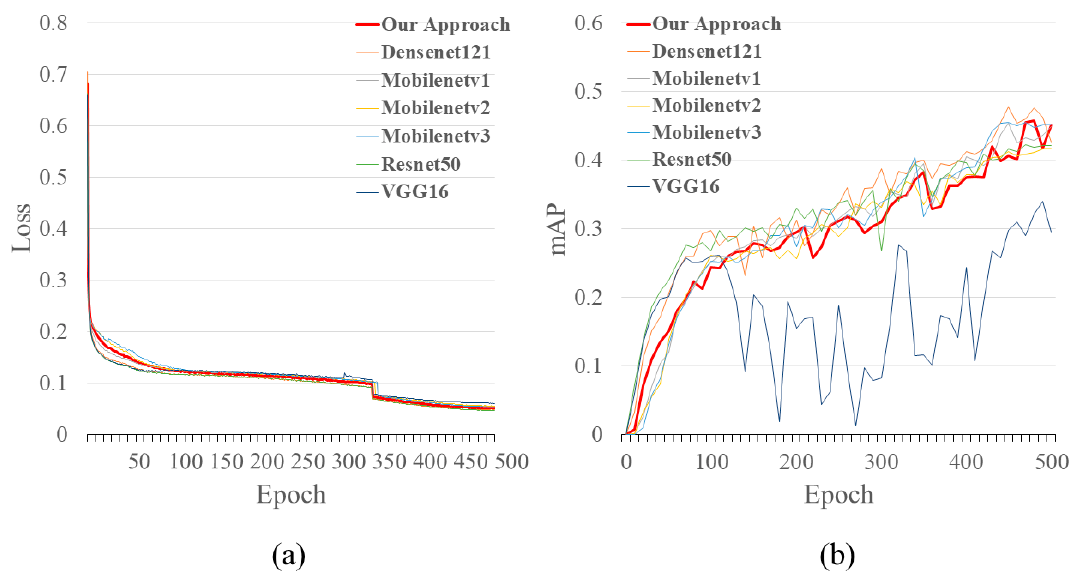
Figure 8. The upward trend of ( a ) loss function convergence status and ( b ) mAP for each model at 500 training epochs. Table 9. Comparison of quantitative experimental results on the same test set, where bold numbers indicate the best value for each column, where the Precision and Recall calculated in this paper represent when the threshold value is